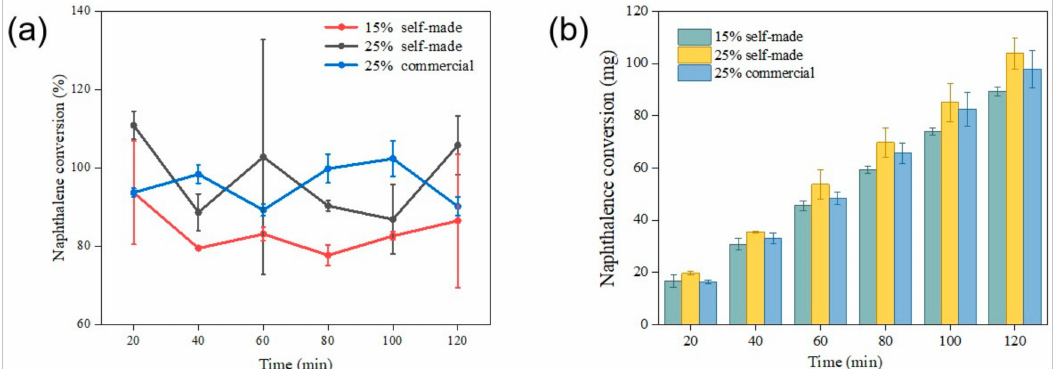
Figure 9. The Naphthalene conversion ( a ) rate (%) and ( b ) amount (mg) with different catalysts and associated loading rates on tar catalytic reforming in 2